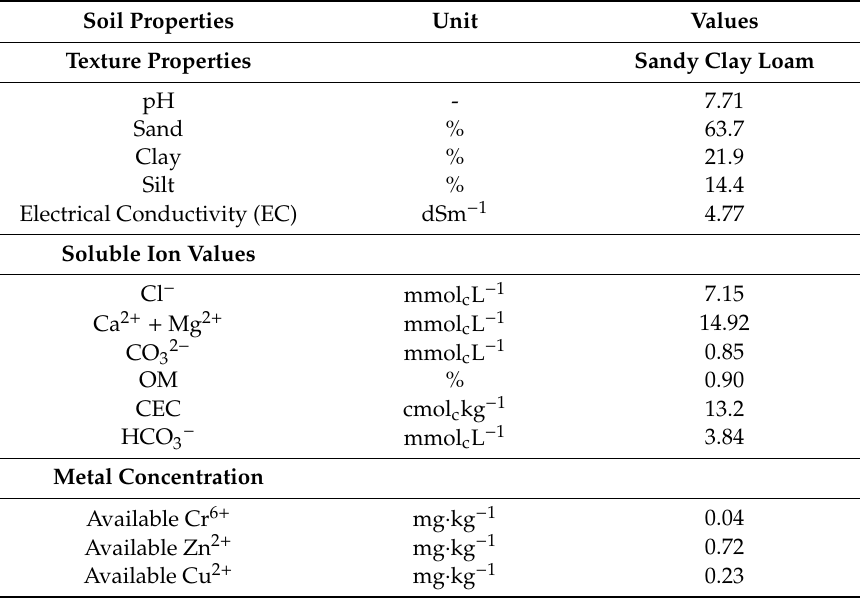
Table 1. Soil characterization of pot